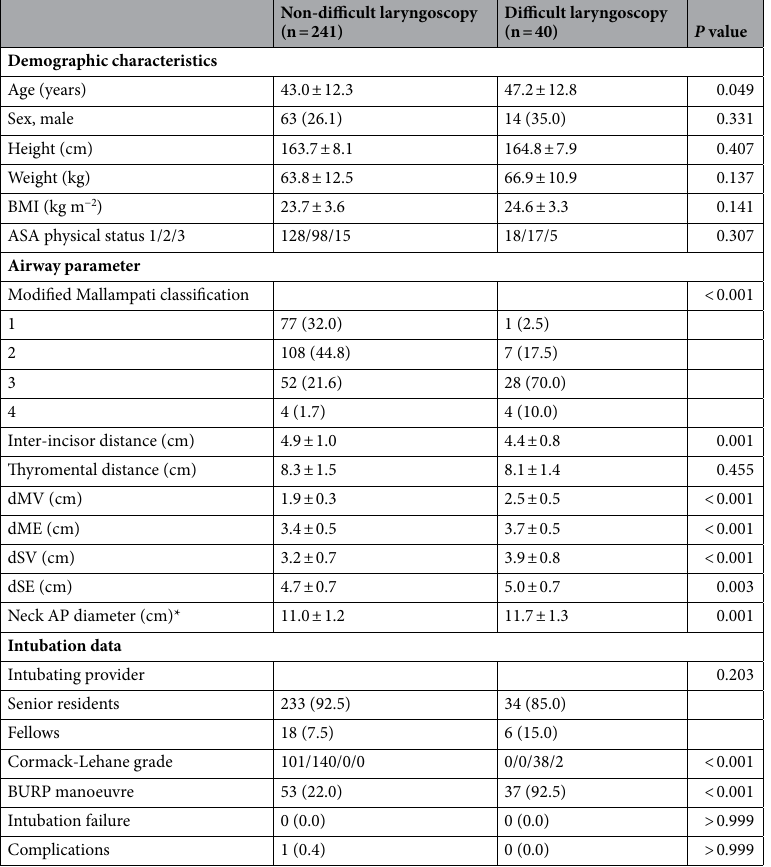
Table 1. Demographic characteristics, airway parameters and intubation data in the non-difficult laryngoscopy and difficult laryngoscopy groups. Data are presented as mean (standard deviation), number, or number (proportion). AP, anterior–posterior; ASA, American Society of Anaesthesiologists; BMI, body mass index; BURP, backward, upward, rightward pressure; dME (membrane-to-epiglottis distance), distance from the midpoint of thyrohyoid membrane between the hyoid bone and laryngeal prominence to the furthermost tip of the epiglottis; dMV (membrane-to-vallecula distance), distance from the midpoint of the thyrohyoid membrane between the hyoid bone and laryngeal prominence to the closest concave point of the vallecula; dSE (skin-to-epiglottis distance), extended distance straight to the skin anterior from the dME; dSV (skin-to- vallecula distance), extended distances straight to the skin anterior from the dMV. *One patient from the non- difficult laryngoscopy group is excluded because of missing neck AP diameter data due to the impossibility of measurements owing to a tracheal deviation by